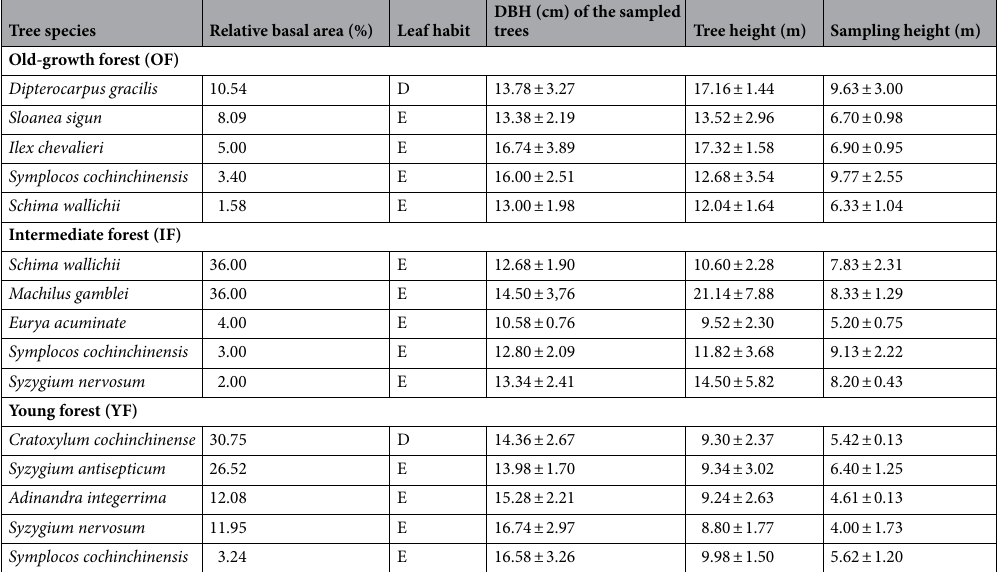
Table 1. Characteristics of dominant tree species from the study sites of different forest succession in Khao Yai National Park. Relative basal area refers to the percentage of total basal area of the species to total basal area of all trees within the plot. Leaf habit shows whether the species is deciduous (D) or evergreen (E). For each species, diameter at breast height (DBH; cm), tree height (m) and sampling height (m), at which the sampled leaves were taken, are expressed in mean ± SD values of the sampled